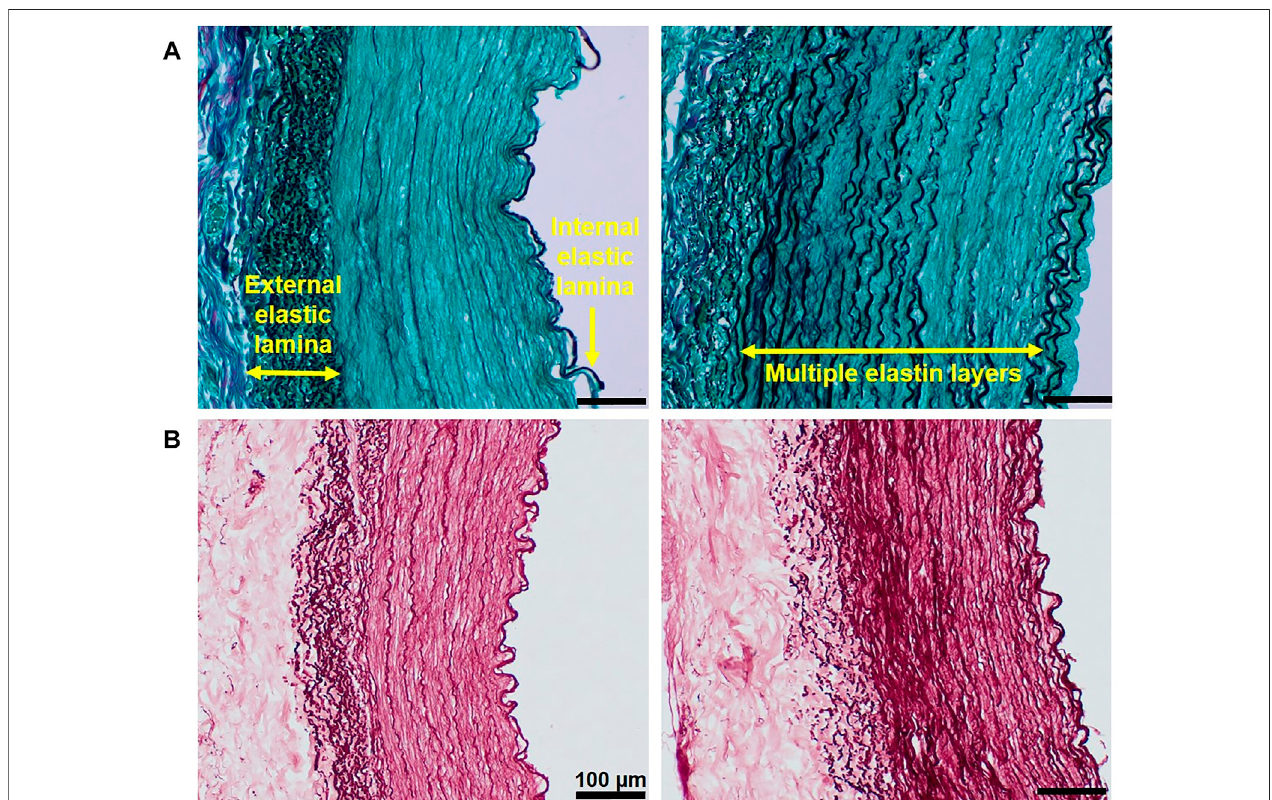
FIGURE3| Visualizationofthehighlyvariablepresenceofelastic fi bersindecellularizedarteries:BlackcolorinVerhoeff ’ sgreentrichrome – stainedsamples (A) and darkredcolorinorcein-stainedsamples (B) representelastic fi berswhicharealwayspresentinexternalandinternalelasticlamina;however,theamountofthese fi bersin tunica media is much lower in the sample on the left-hand side (weaker staining of elastic layers) than in the multiple elastic layers strongly stained in the sample on the right-hand side. The scale is the same for all the fi gures (100 µm).